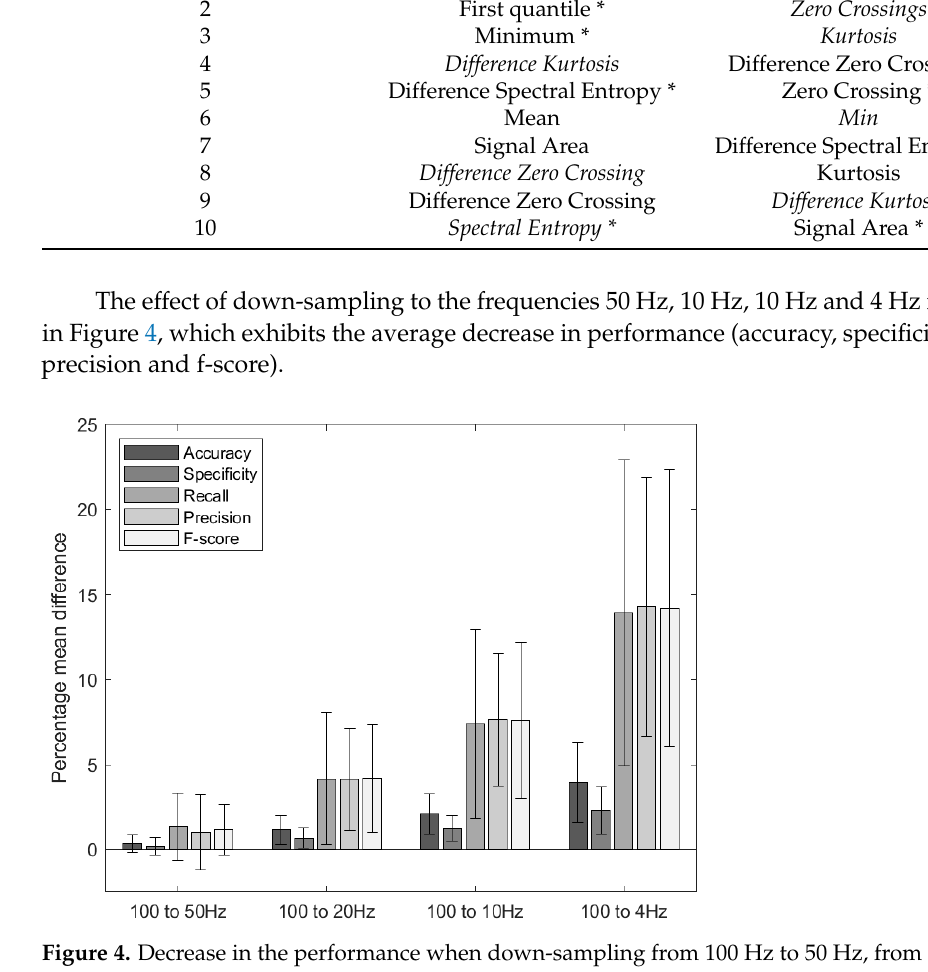
Figure 4. Decrease in the performance when down-sampling from 100 Hz to 50 Hz, from 100 Hz to 20 Hz, from 100 Hz to 10 Hz and from 100 Hz to 4 Hz. The bars show the average decrease across all the different behaviours, the black error bars show the variation in reduction (s.d) across the different behaviours.